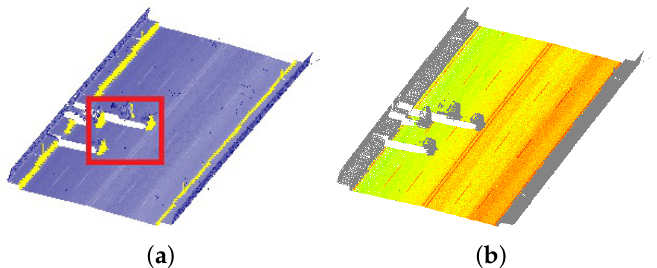
Figure 6. ( a ) The yellow points present the result of the search for curb grids. The red box indicates the vehicle points that are incorrectly recognized as curbs. ( b ) The colored points are the retained road points, and the gray points are the removed points. The precise road is obtained, and the vehicles are